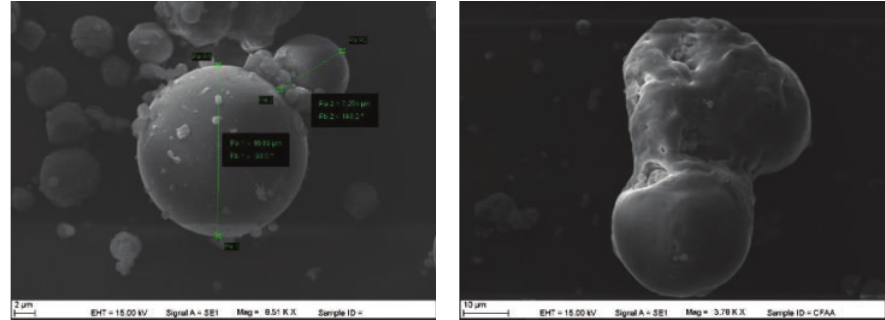
Figure 5: The scanning electron microscope (SEM) views of regular and irregular shaped glass beads of YFA.